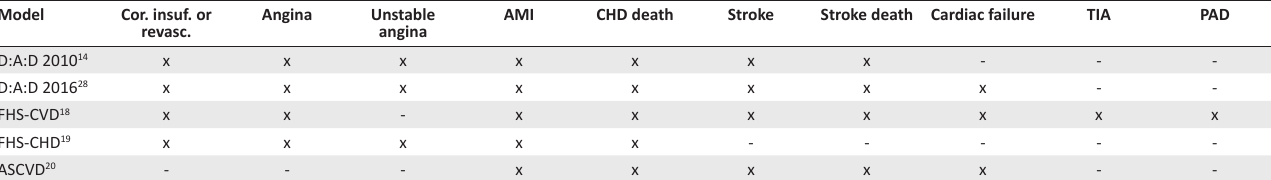
TABLE 1-A1: Endpoint definitions used by the cardiovascular disease risk prediction models. Model Cor. insuf. or revasc.